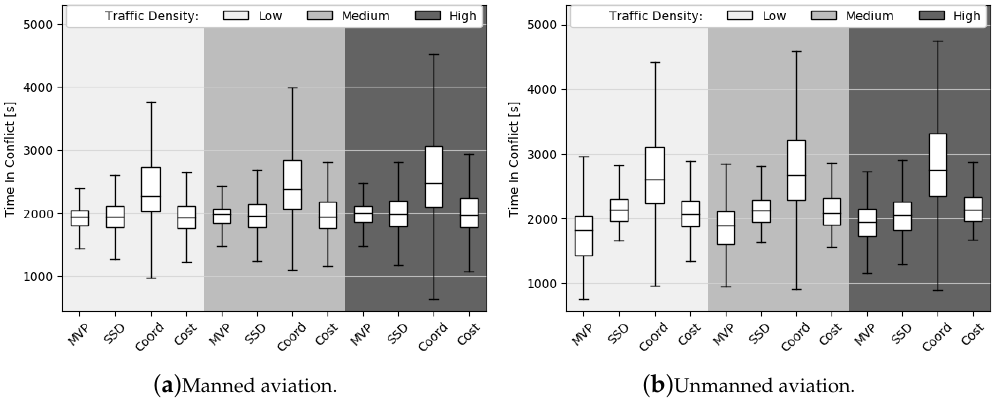
Figure 12. Time in conflict per flight and per CD&R method.